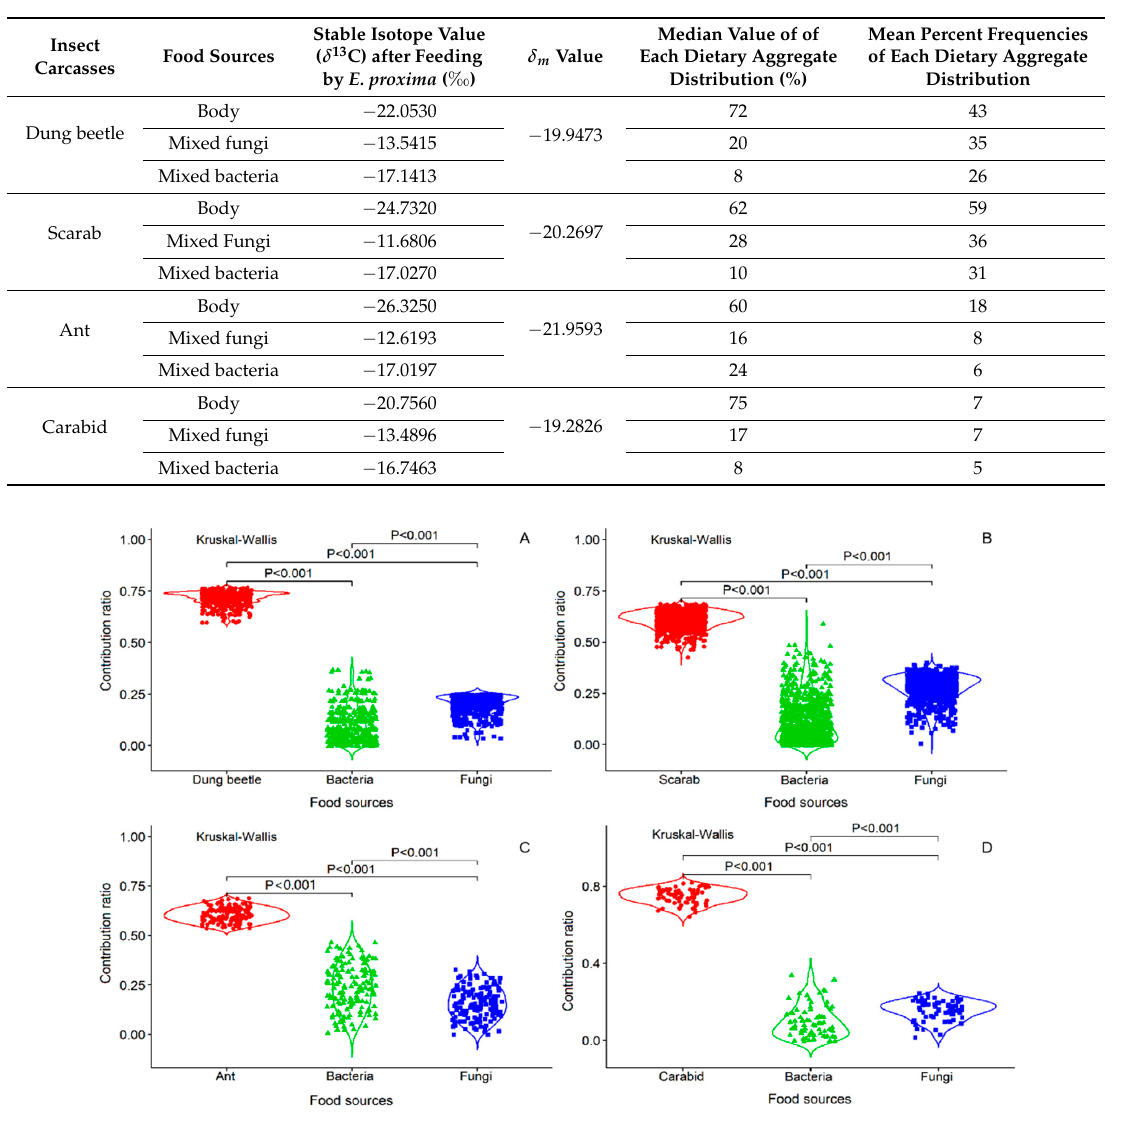
Figure 1. The bodies of four insects and microorganisms (fungi and bacteria) growing on insect bodies are the three types of food sources. Comparing each of the weighted averages of the number of combinations with the δ m , the comparative values for which the mass balance tolerances are between − 0.1 ‰ and 0.1 ‰ are retained. For the contribution ratio in the figure, each dot represents the comparative values of the acceptable solution for the feeding proportion by E. proxima . Kruskal-Wallis explanatory values are statistically significant at p < 0.001.